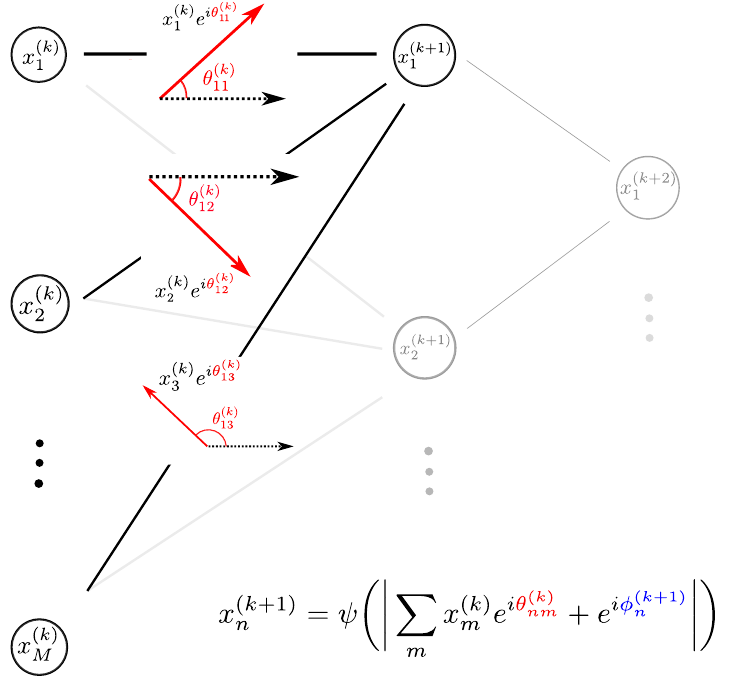
Figure 2 . A schematic diagram to illstrate the modi(cid:12)ed WGAN, where all the weights and biases are angles. The compactness of the unit circle then guarantees that the trained functions are all K -lipschitz for su(cid:14)ciently large K . The inputs to the layer are x 1 ; : : : ; x n and there is a hidden layer with two nodes y 1 and y 2 (in general, there can be many more than two) followed by a single output layer z 1 . The equation shows the form of the activation that maps x 1 ; : : : ; x n to y 1 . where x ( k ) m represents the output of the m -th neuron in the k -th layer of the neural network and is the activation function. The bias is replaced by b = e i(cid:30) n and the weights are i ( k ) replaced by w = e i(cid:18) nm nm